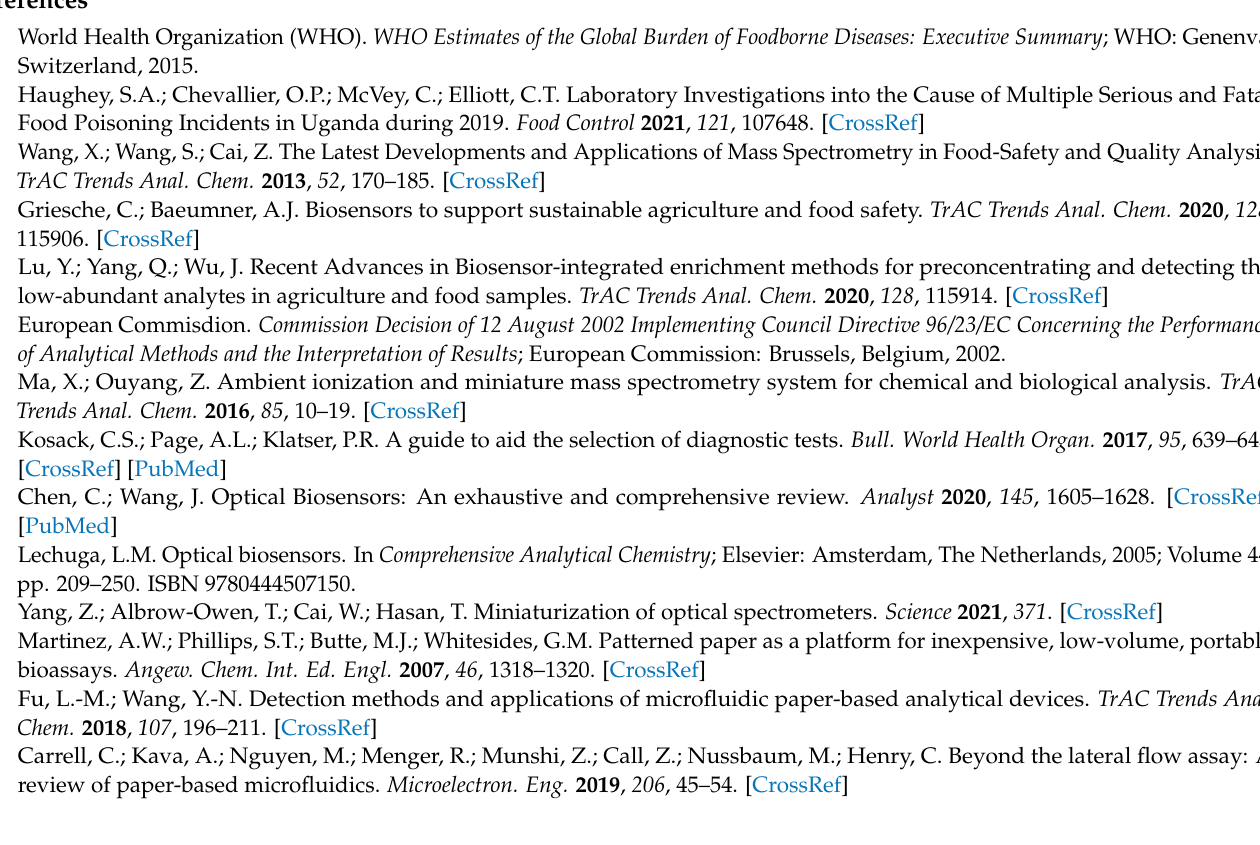
Table S2: microfluidic chip-based optical food analyzers, spreadsheet Table S3: smartphone-based op- Table S5: paper-based electrochemical food analyzers, spreadsheet Table S6: microfluidic chip-based electrochemical food